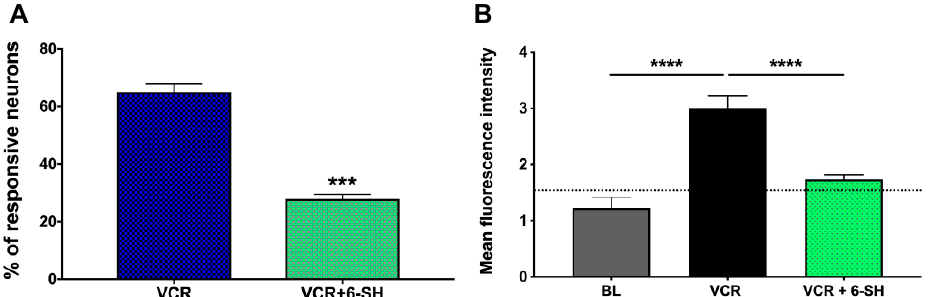
Figure 5. Ginger constituent 6-shogaol significantly attenuated vincristine-induced activation re- sponses in gastroesophageal vagal afferent neurons. ( A ) The percentage of responsive neuron in the vincristine (VCR, 1 μ M, 30 min) group was 65 ± 5% (167 out of 257 recorded neurons from three mice). In the group (VCR + 6-shogaol) that was pretreated with 6-shogaol (100 μ M) for 30 min, and then vincristine (1 μ M) in the presence of 6-shogaol (100 μ M) was applied for 30 min, the percentage of vincristine responsive neurons significantly went down to 28 ± 3% (92 out of 329 recorded neurons from three mice)(VCR vs. VCR + 6-shogaol, *** p < 0.001); ( B ) The mean fluorescence intensity in the VCR group was 3.005 ± 0.2195, which significantly went down to 1.737 ± 0.0786 in the 6-shogaol treatment (VCR + 6-SH) group (VCR vs. VCR + 6-SH, **** p <